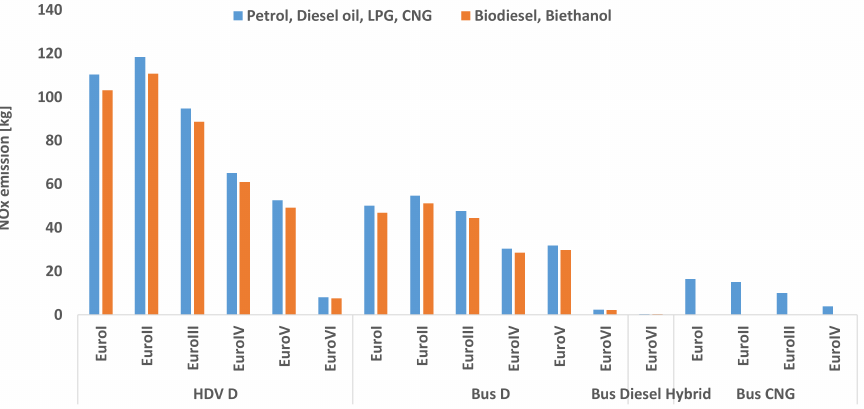
Figure 10. Comparison of NO X emissions from HDVs and buses depending on Euro standard and fuel